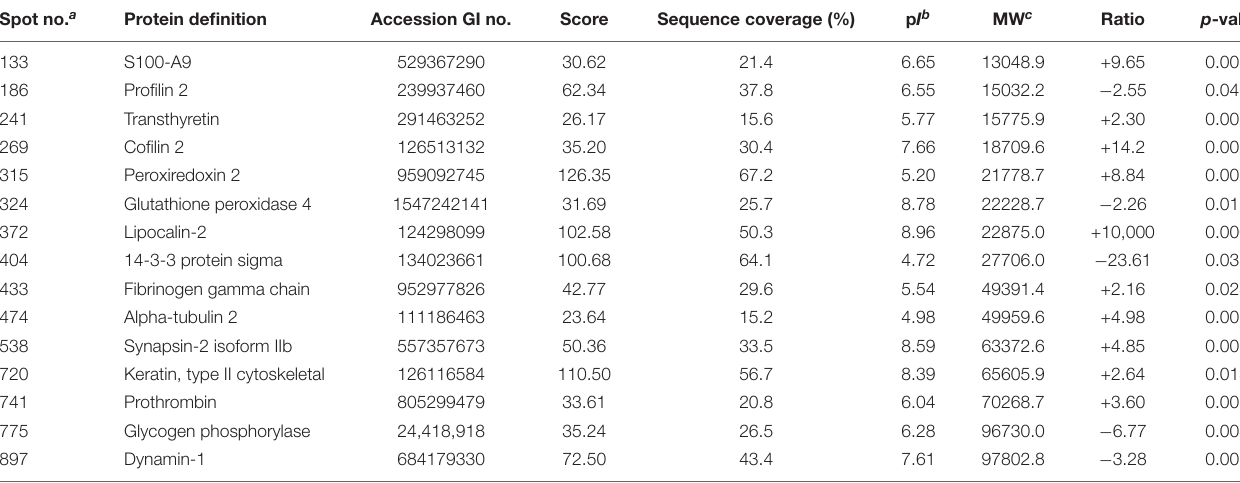
TABLE 1 | Differentially expressed proteins in the hippocampus of CP mice model as compared with controls. Spot no.